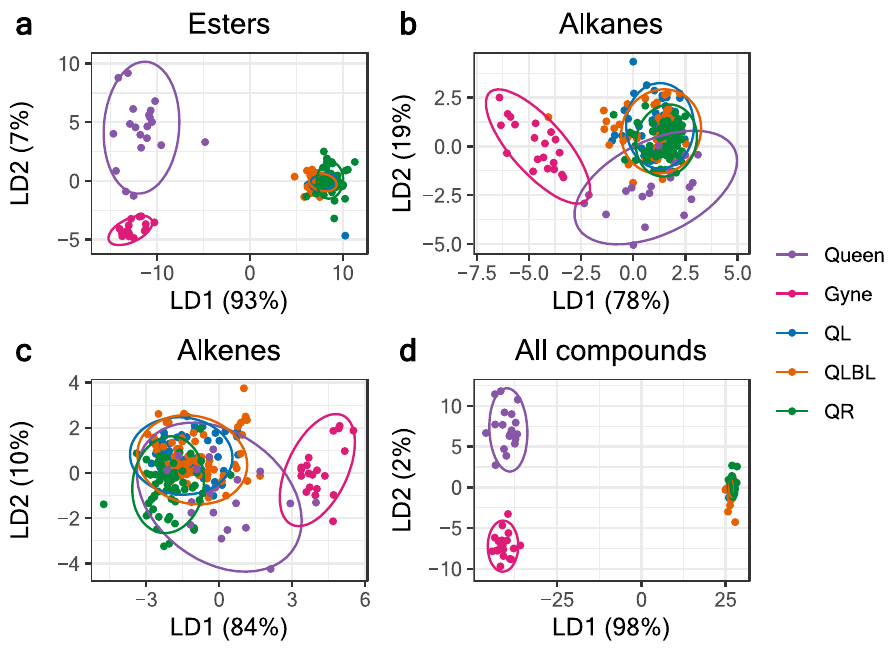
Figure 1. Linear discriminant analyses on Aitchison’s Z-transformed relative peak areas of Dufour’s gland extracts of workers of three social conditions (queenright – QR, queenless—QL, and queenless, brood-less— QLBL), gynes, and queens, with caste/treatment as the grouping variable. Each point is an individual bee. Panels (a – d ) show the clustering generated by plotting the first two linear discriminant functions using the esters, alkanes, alkenes, or all